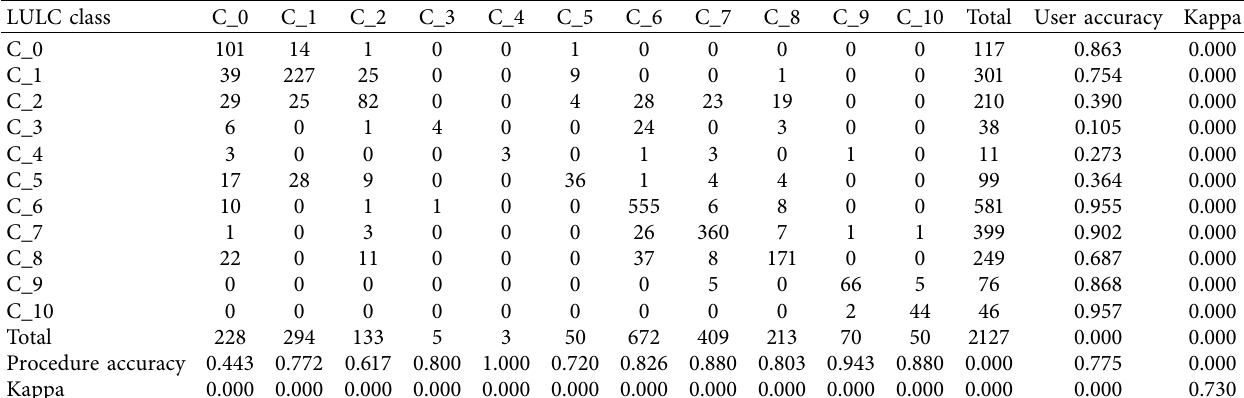
Table 6: Result of the accuracy assessment for the LULC classification based on the SVM classifier without the MaSegFil approach. LULC